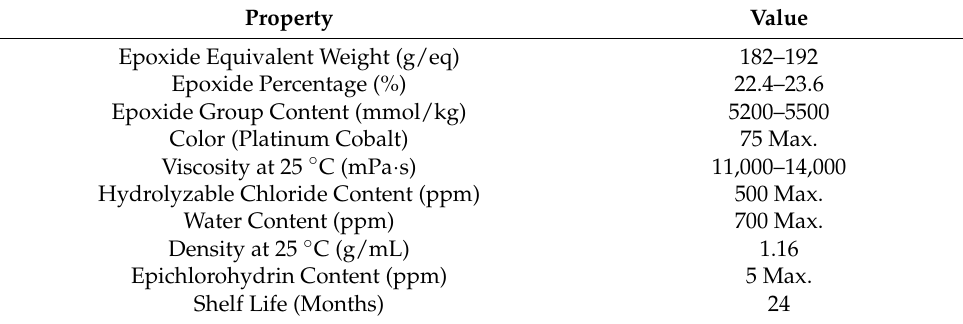
Table 1. Properties of epoxy resin D.E.R * 331.